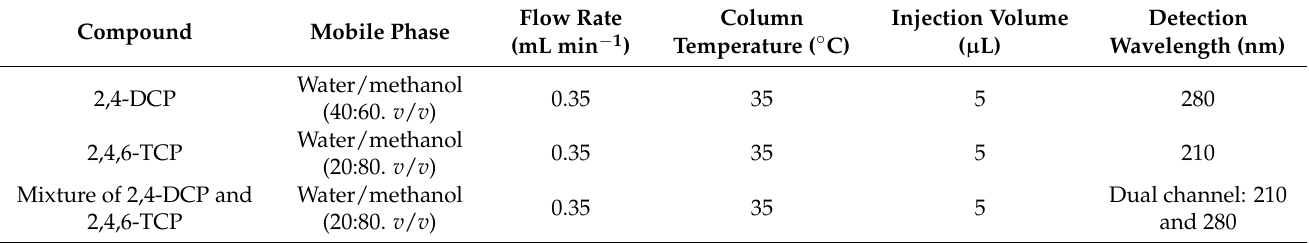
Table 1. UPLC methods for target